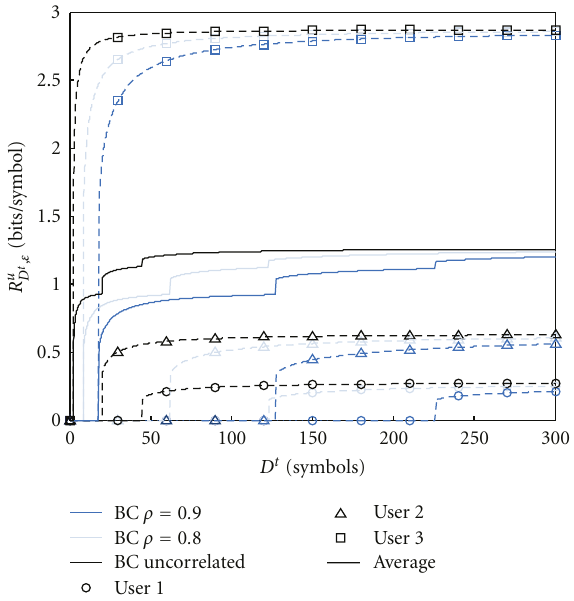
Figure 7: Achievable users’ rates with Best Channel scheduling in a time-correlated channel with exponential ACF of parameter ρ . = 5,7,12 dB, respectively. ε = 0 . 1. β Three users with γ u